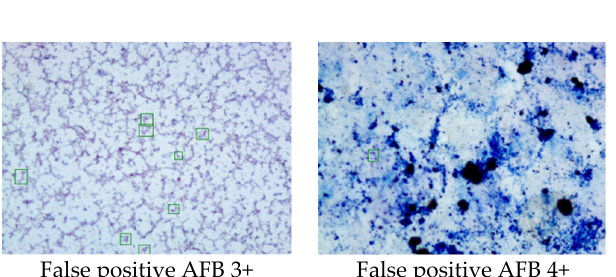
Figure 5. The confusion matrix of automation system with 200 images capture setting. Figure 6. The confusion matrix of automation system with 200 images capture setting after removal of inadequate cases.